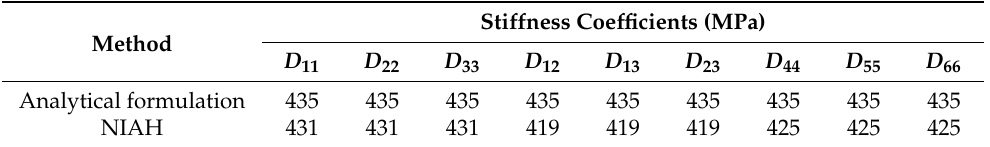
Table 1. The equivalent material’s stiffness coefficients of the specified BCC lattice from different